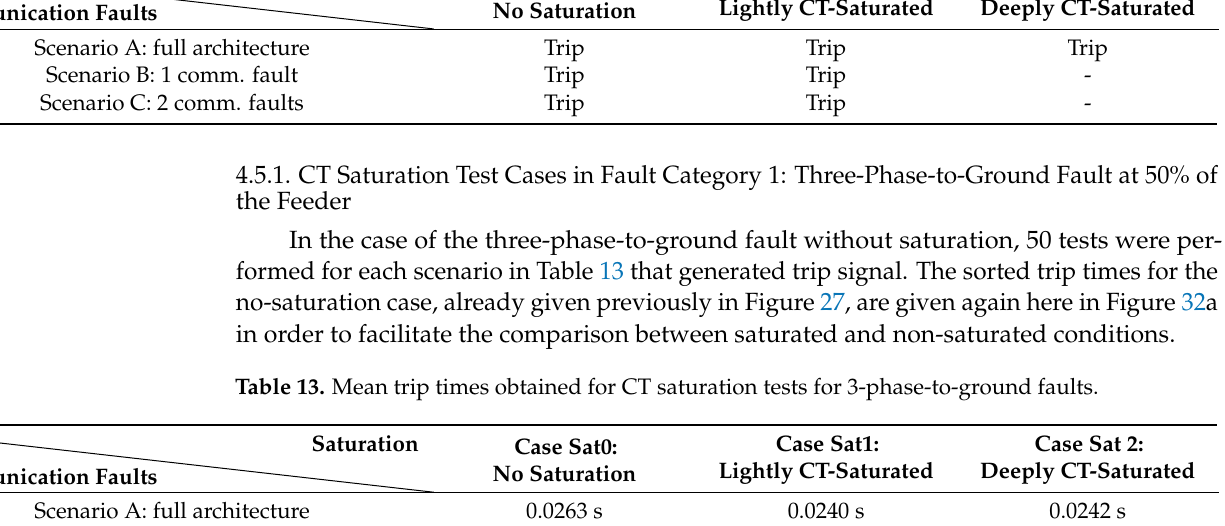
Table 12. Trip signals obtained for CT saturation tests for all types of faults applied. Saturation